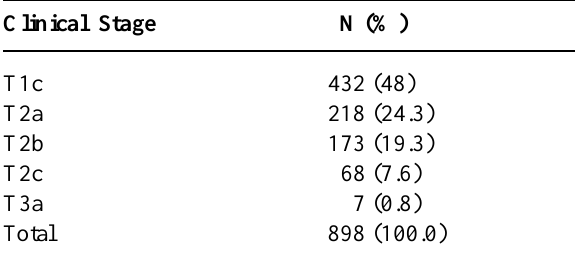
Table 1 – Patient distribution according to clinical